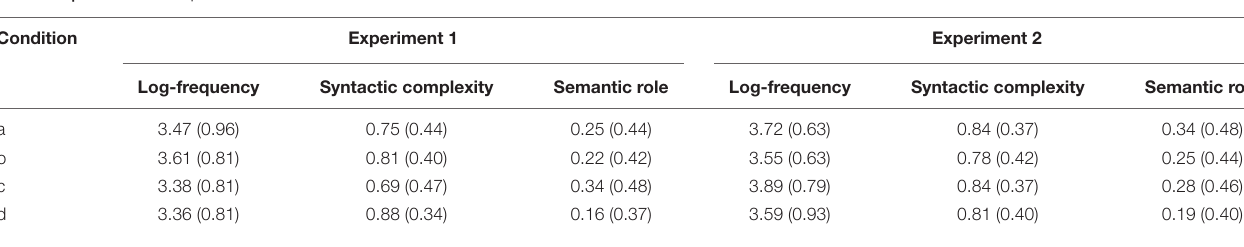
TABLE 3 | Parameters of predicates in C2.